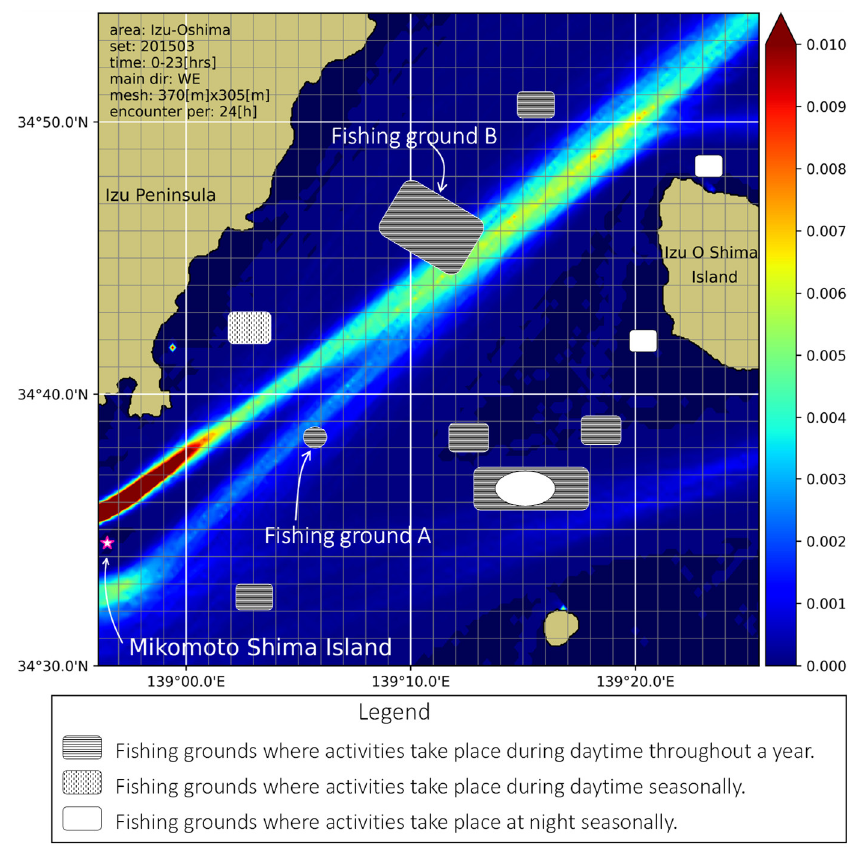
Figure 8. Fishing grounds and encounter frequency distribution from AIS data. (Sources: fishing grounds data in [8] and AIS data from 1 March to 31 March 2015, provided by TST